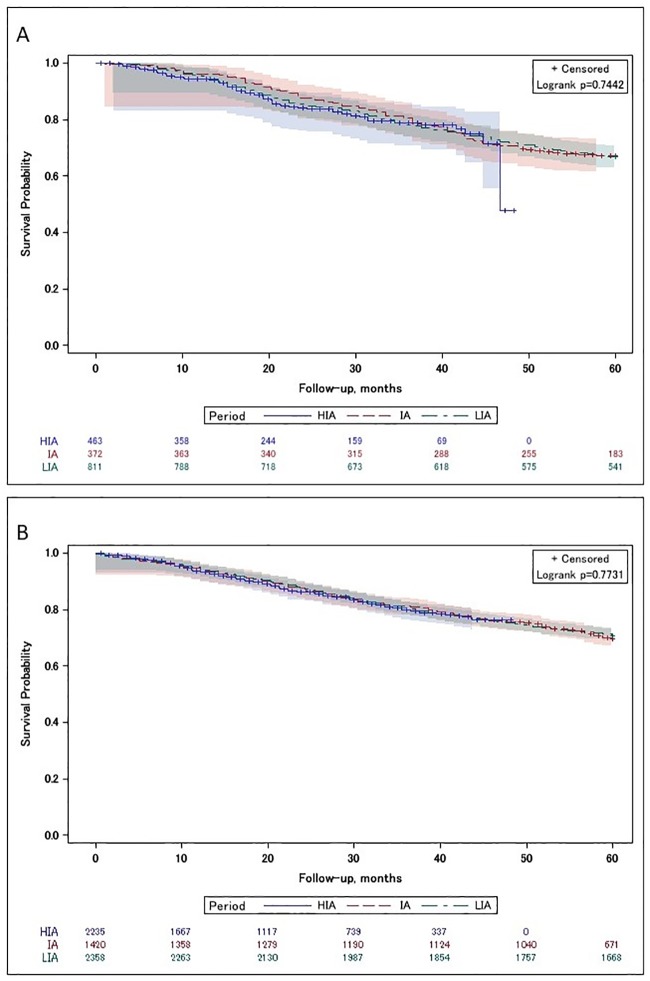
Kaplan–Meier survival curves with number of subjects at risk and 95% Hall–Wellner bands for the (A) No PORT and (B) PORT study population in a pN0 situation, related to the treatment periods.IMRT = intensity-modulated radiotherapy, LIA = low IMRT availability period, IA = intermediate IMRT availability period, HIA = high IMRT availability period.